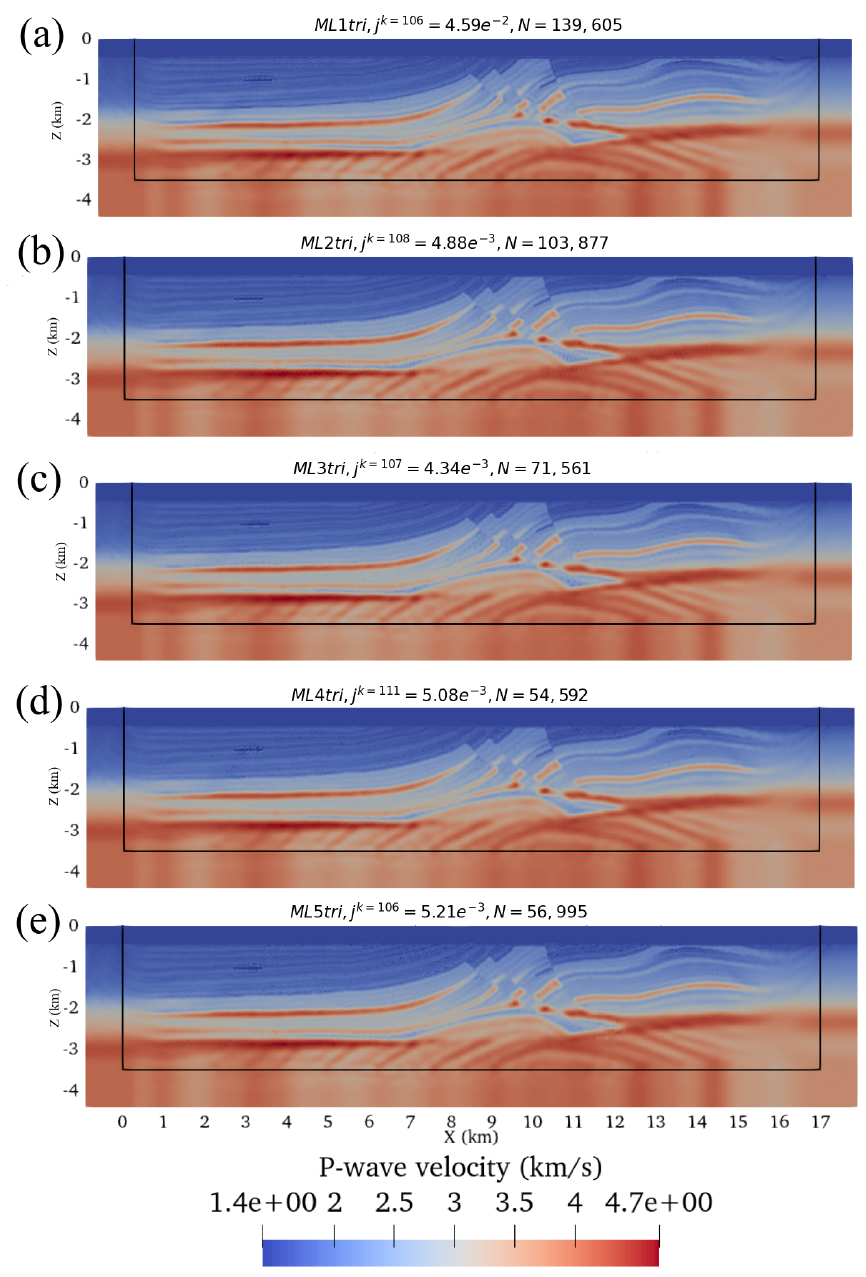
Figure 16. The final result for each FWI using different ML elements. The total number of iterations (including both iterations that reduced the cost functional and the ones that did not) are indicated in each figure along with the final J and number of degrees of freedom N